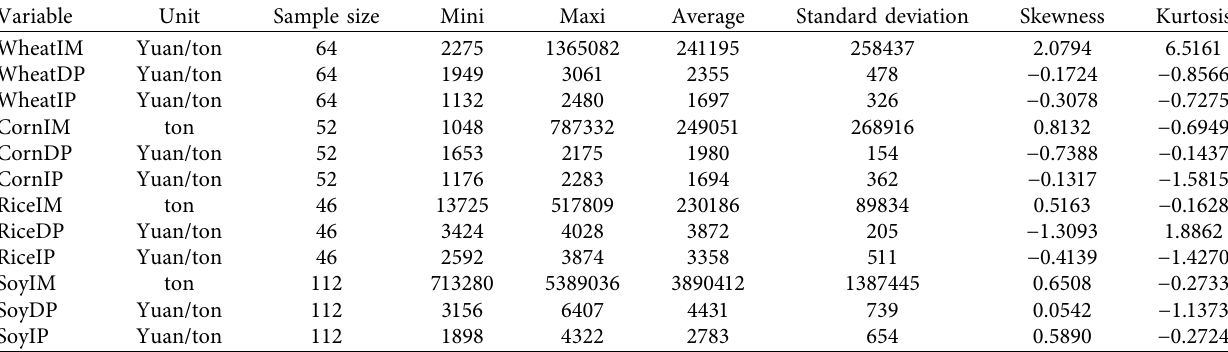
Table 2: Statistical analysis results of the description variable.